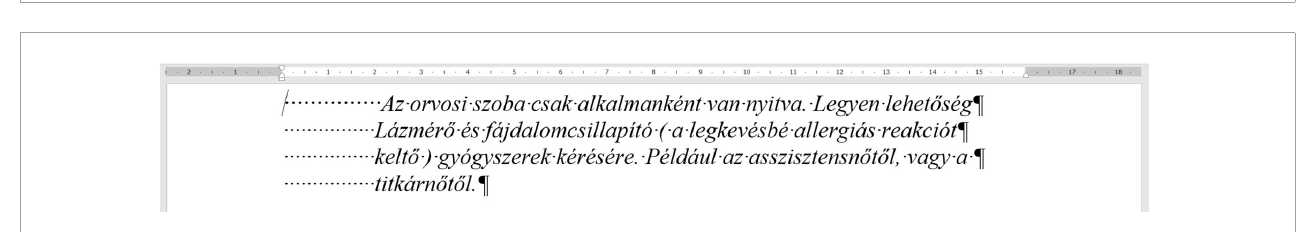
FIGURE6 The ruler and the non-printing characters reveal that there is no left indent set up, and the section consists of four paragraphs.